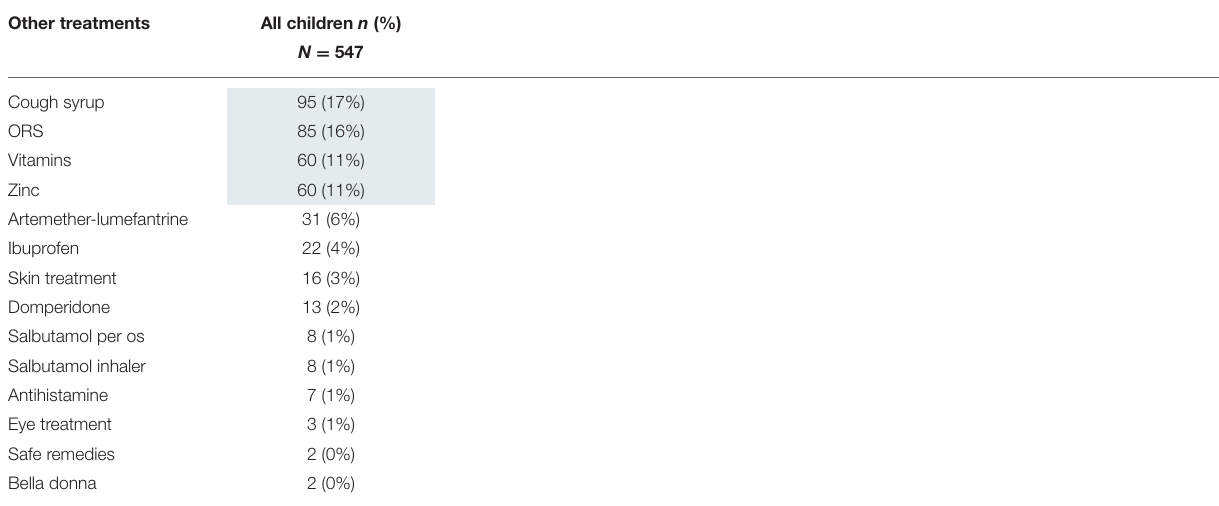
(B) Other treatments prescribed in all children Other